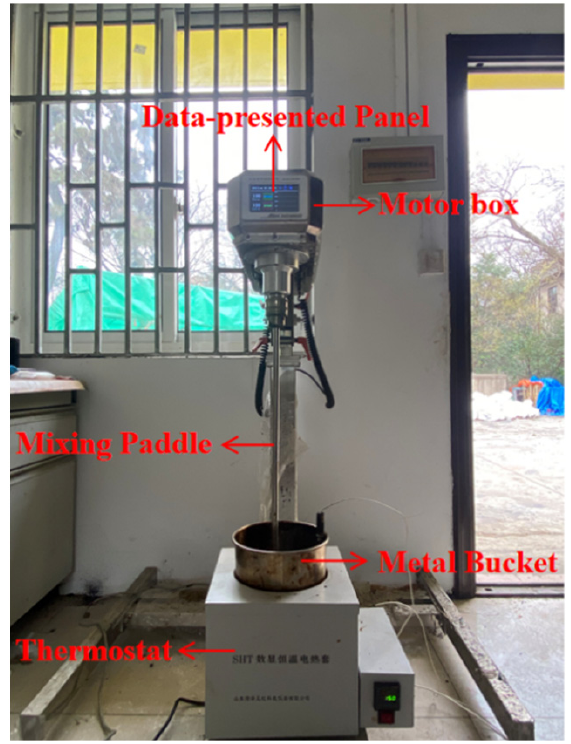
Figure 4. Mixing torque tester.